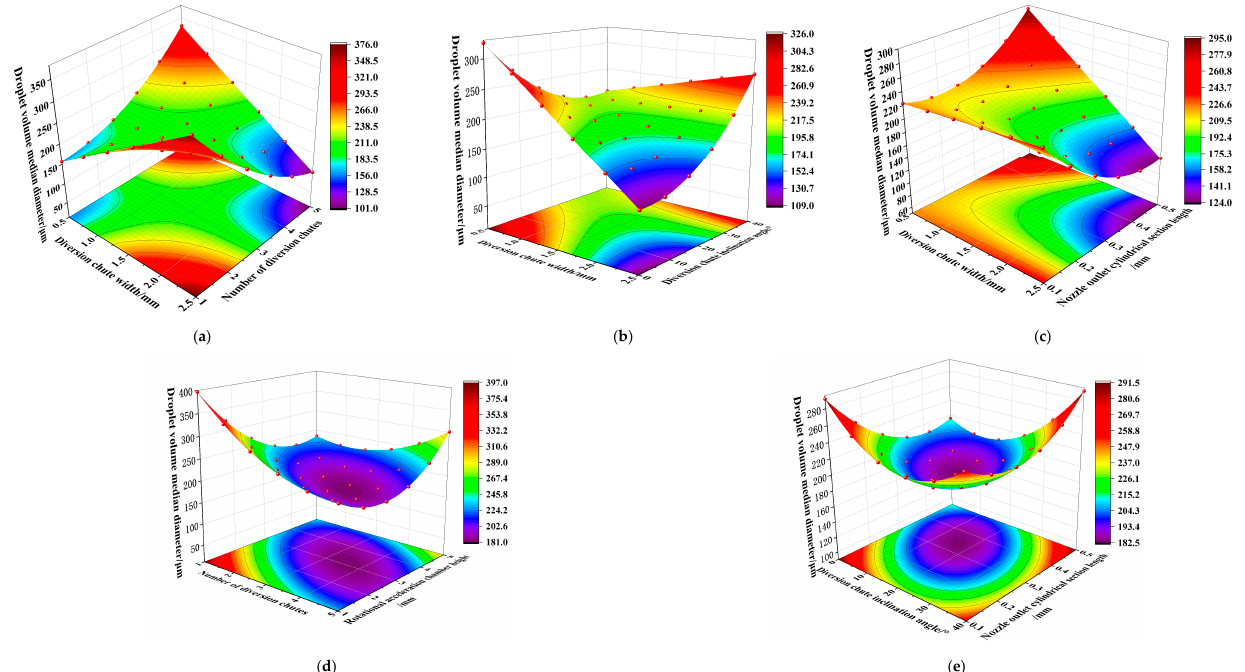
Figure 11. Two-factor interaction effect diagram of the droplet volume medium diameter. ( a ) Interaction effect between b and n , ( b ) interaction effect between b and β , ( c ) interaction effect between b and h 2 , ( d ) interaction effect between n and h 1 , ( e ) interaction effect between β and h 2.